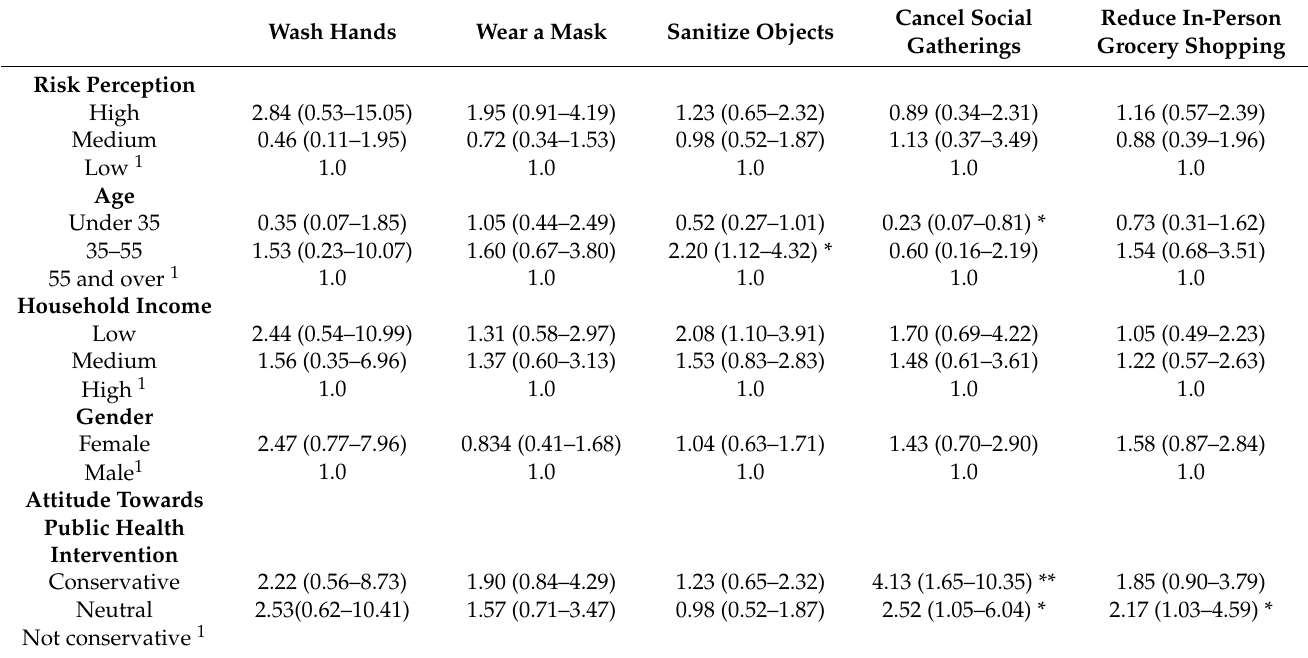
Table 4. Logistic regression analysis assessing the factors associated with the level of prevention in April (lockdown stage): odds ratio and 95% confidence